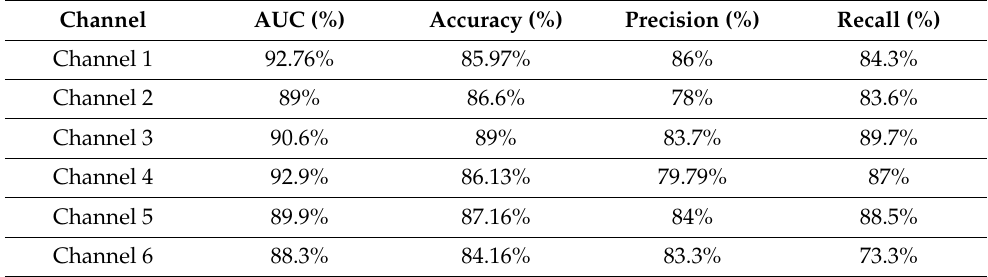
Table 4. Accuracy, area under curve (AUC), precision and recall results for model 1, 10 s epochs.